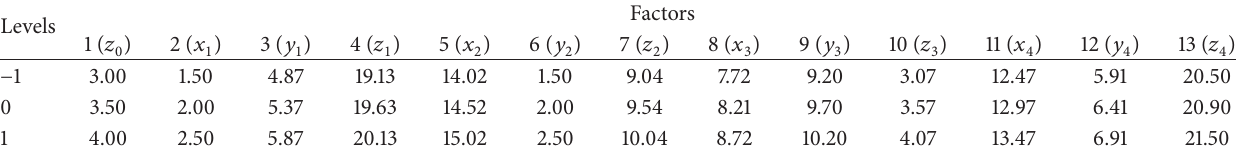
Table 5: ST5 antenna design with 13 factors and 3 levels each.